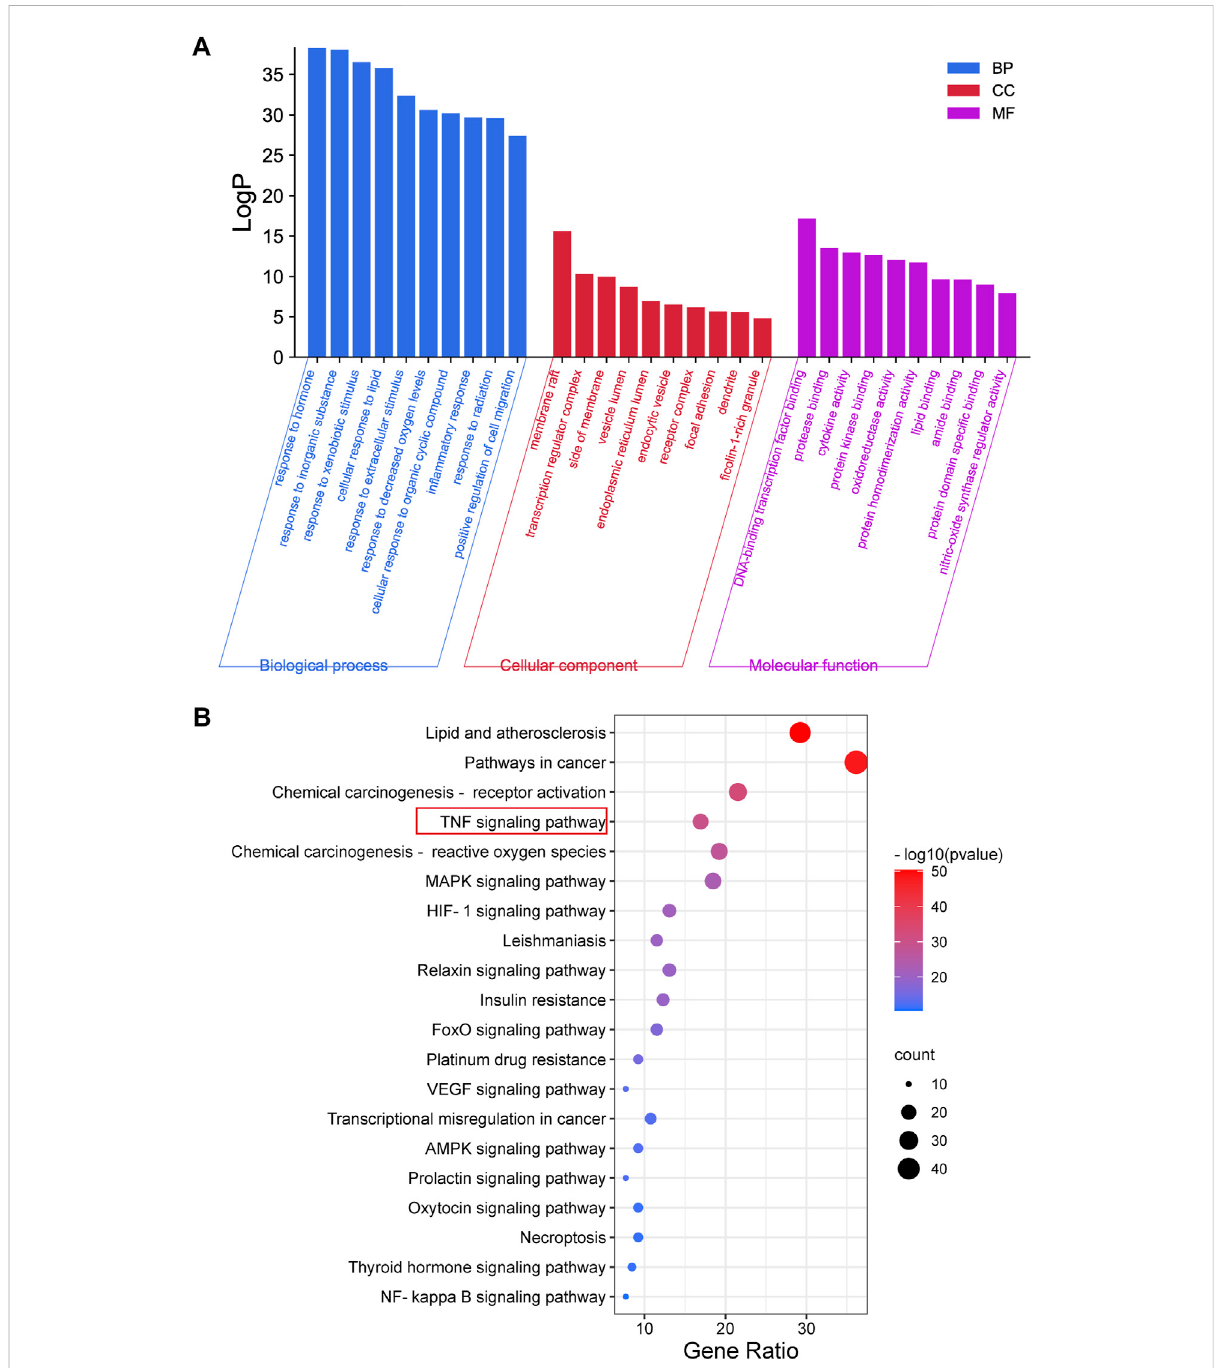
FIGURE 3 GO and Pathway Enrichment Analysis. (A) The GO enrichment analysis for overlapping targets between CSP and NAFLD. (B) KEGG pathway enrichment analysis of overlapping targets between CSP and